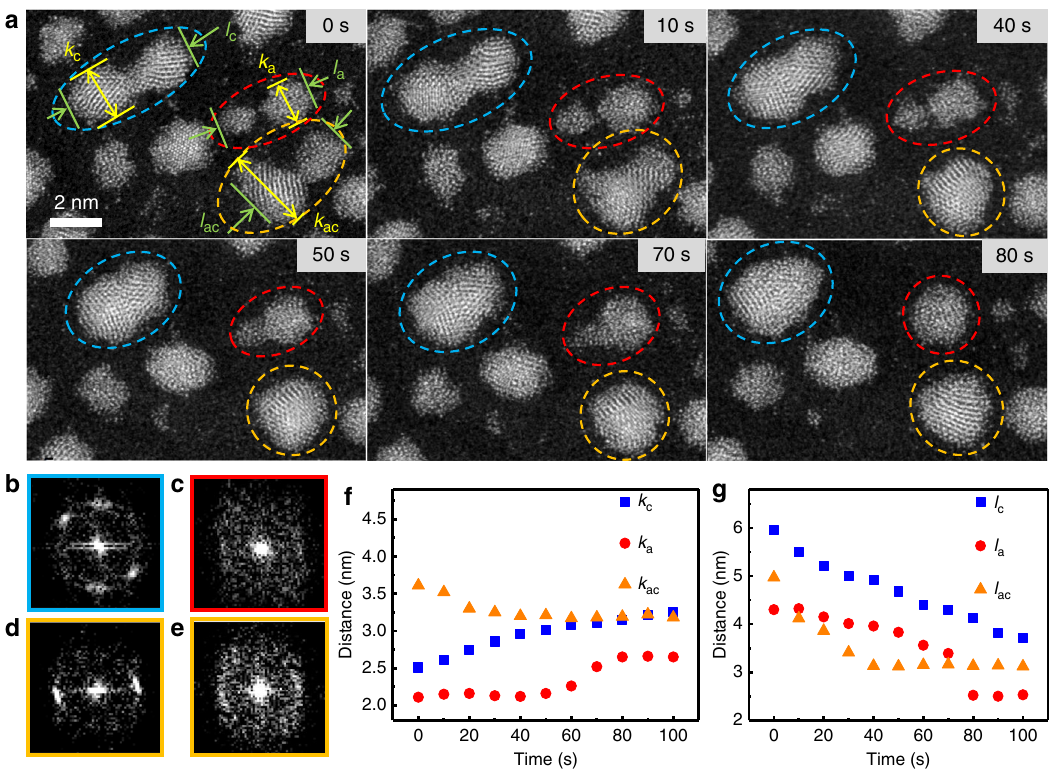
Fig. 4 In situ observation of coalescence process under Cs-STEM. a A series of Cs-STEM images with the times as labeled. The coalescence of the c-NP, a- NP and a-c-NP pairs are marked by blue, red and orange dashed circles, respectively. b The local area fast Fourier transforms (FFT) of the c-NP pair (in blue circle) at 0 s. c FFT of the a-NP pair (in red circle) at 0 s. d , e FFT of the c-NP and a-NP of the a-c-NP pair (in orange circle) at 0 s, respectively. f , g The time dependences of the sizes of the NP pairs, marked as distances of k c , k a , k ac , l c , l a , and l ac , respectively. The surface liquid-like layer in the c-NPs accelerated and fi nished the coalescence process before rotating of the c-NPs to match perfect